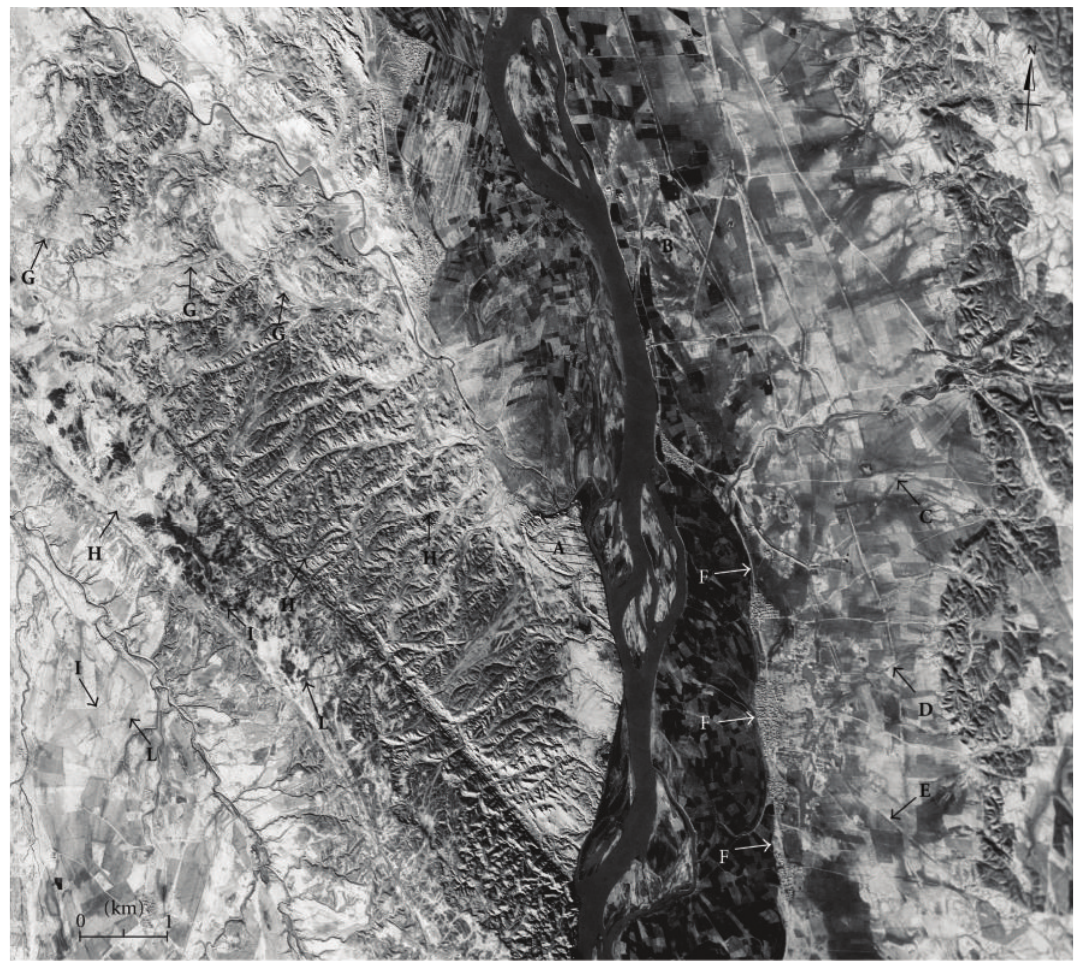
Figure 2: The area of Ashur (A) and Kar-Tukulti-Ninurta (B) in a Corona KH-4B image of 1967; traces and remains of ancient roads (C, D, E, G, H, and I) and a relict river meander of the Tigris (F) are also